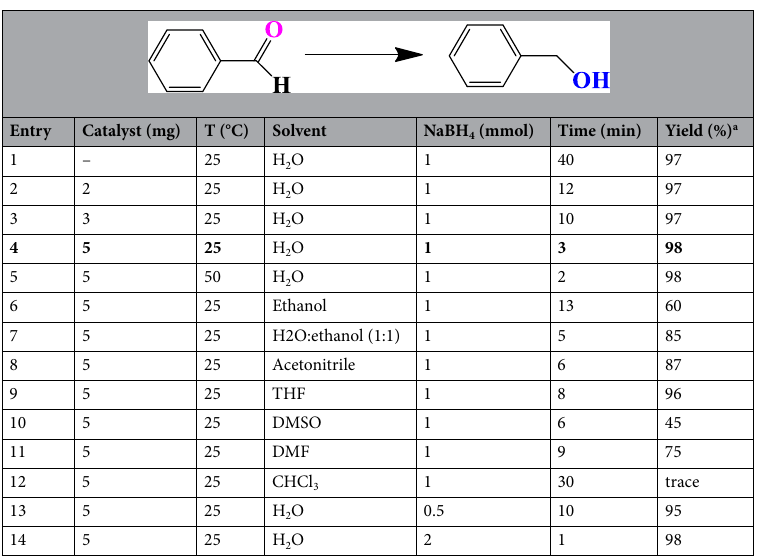
Table 1. The effect of biochar/Fe 3 O 4 –Ag nanocatalyst amount, temperature, solvent, and NaBH 4 . Significant values are in bold. Reaction condition: benzaldehyde (0.5 mmol), solvent (2 mL). a Isolated